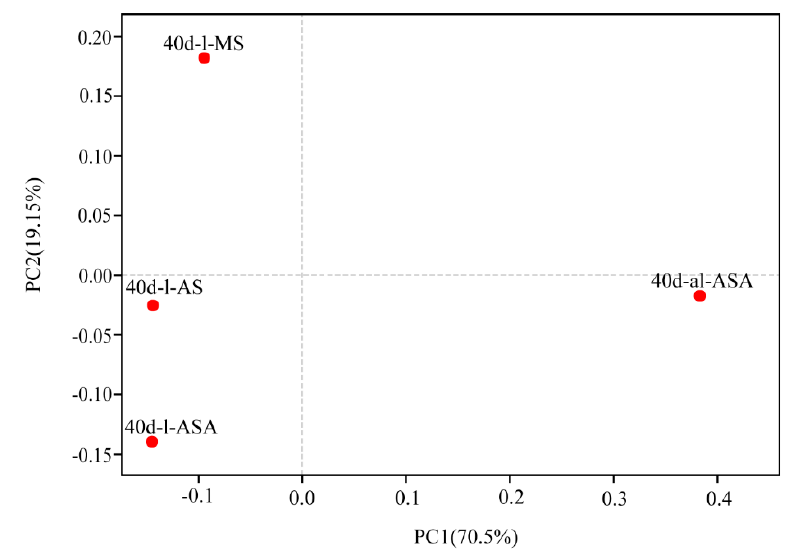
Figure 11. PCoA plot of bacterial communities on the leaves of V. natans on phylum level. (Notes: 40d-l-MS is leaf of the last day in group MS, 40d-l-AS is leaf of the last day in group AS, 40d-l-ASA is leaf of the last day in group ASA, 40d-al-ASA is artificial aquatic mat leaf of the last day in group ASA.).